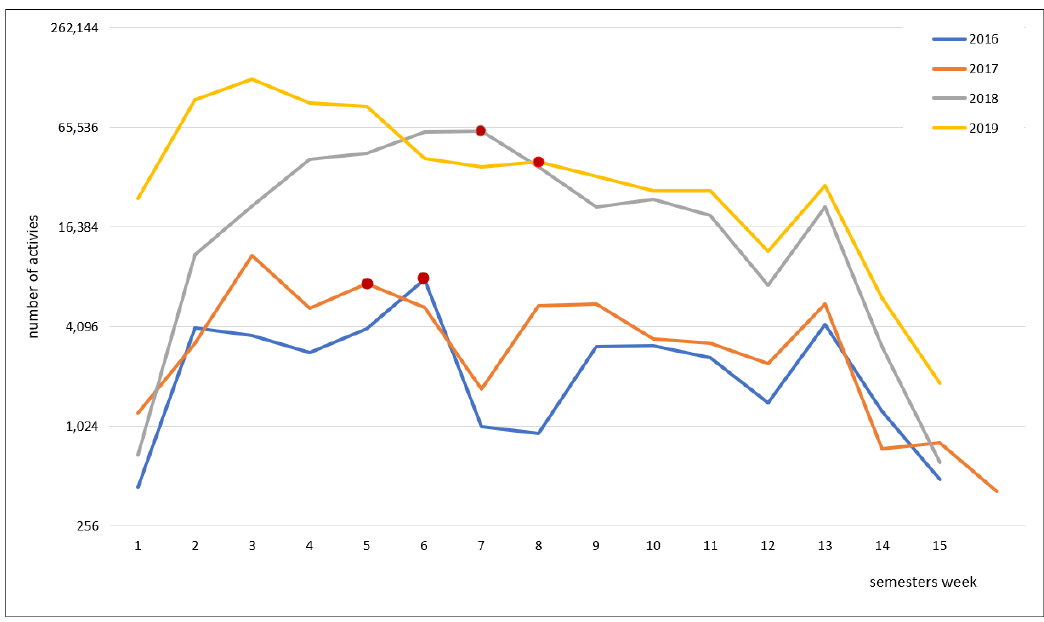
Figure 9. The student's activity expressed by the number of interactions performed in the course in the course during the semester - the x-axis shows the weeks of the semester (from the 1st week to the last (14th or 15th) week of the semester). The y-axis represents number of student’s activities on a logarithmic scale. The red dots indicate the date of the first test. The last test was realised in the 13th week.